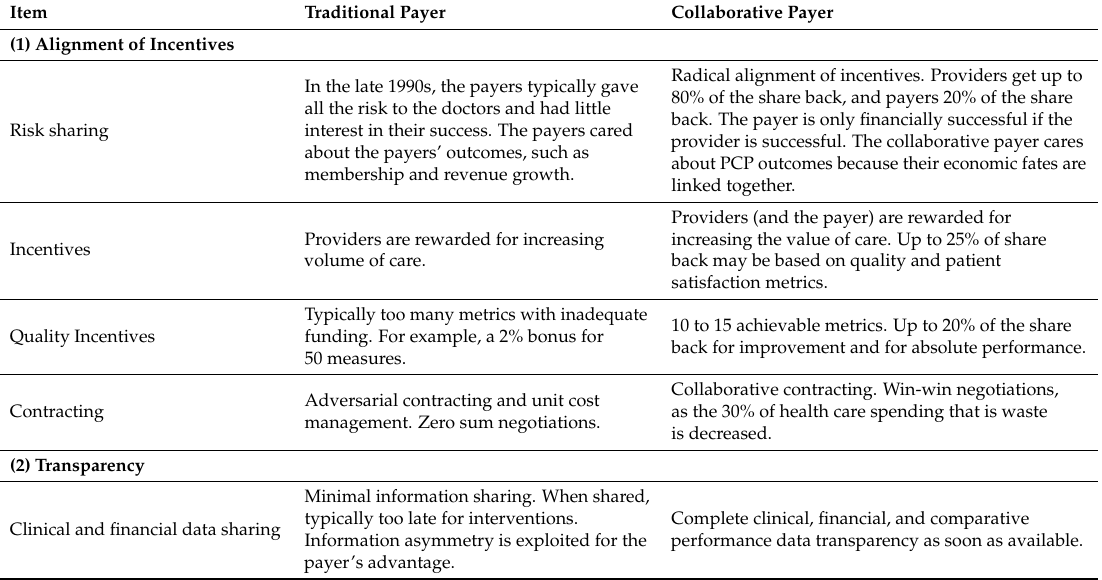
Table 2. Differences between traditional payers and collaborative